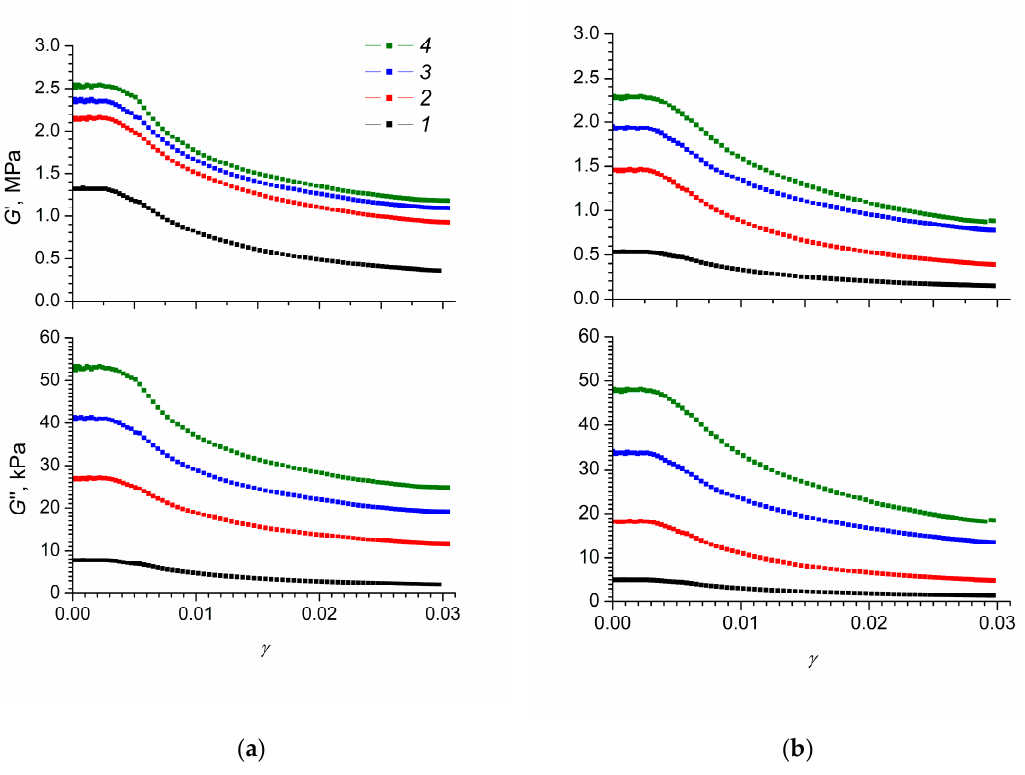
Figure 4. Dependences of storage ( G ′ ) and loss ( G ′′ ) moduli for ( a ) MnO 2 -0 and ( b ) MnO 2 -E composite elastomers on the degree of shear strain γ at various strengths of the electric field applied: 1 —0 kV/mm, 2 —0.4 kV/mm, 3 —1.2 kV/mm, 4 —2 kV/mm. Shear strain rate was 0.05 rad/s.